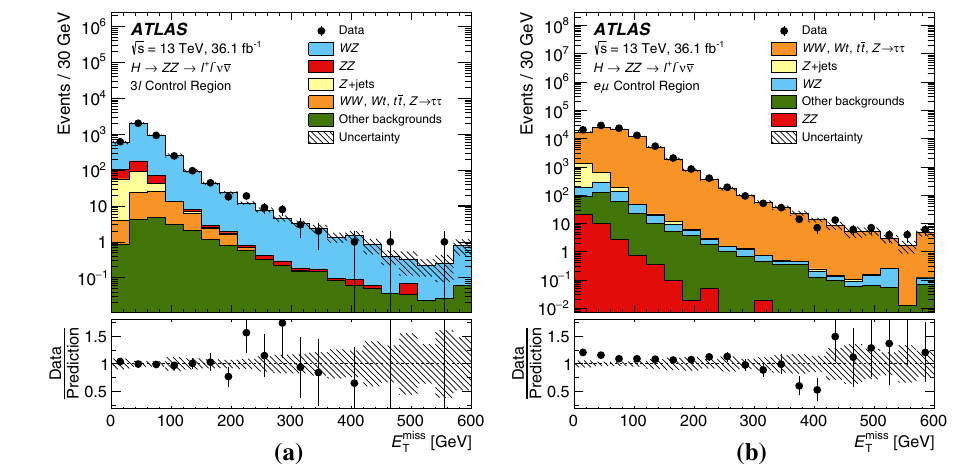
Fig. 3 Missing transverse momentum E miss jets background which is here taken from simulation, and lies outside distribution a for events T the control region. The error bars on the data points indicate the statis- inthe3 (cid:3) controlregionasdefinedinthetextand b for e ± μ ∓ leptonpairs tical uncertainty, while the systematic uncertainty in the prediction is after applying the dilepton invariant mass requirement, before applying shown by the hatched band. The lower panels show the ratio of data to the rest of the control region selection. The backgrounds are deter- mined following the description in Sect. 6.2 and the last bin includes the overflow. The small excess below 120 GeV in ( b ) arises from Z +